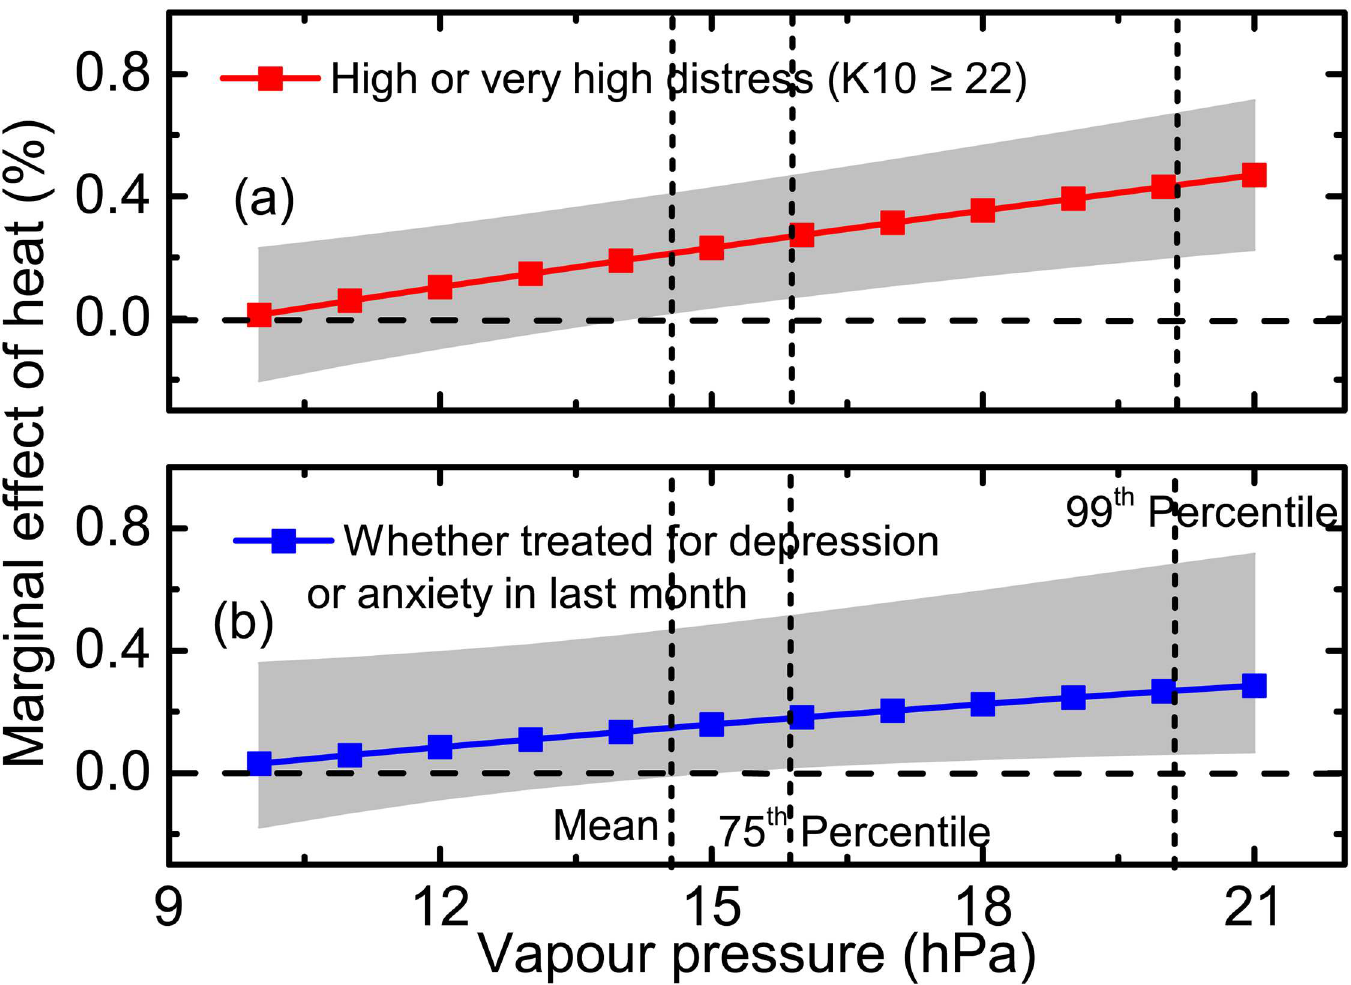
Fig 1. Marginal effects of heat on high or very high distress and on receiving treatment for depression or anxiety by humidity (vapour pressure) and their 99% confidential intervals, Logit model (Model 4), 53,144 adults aged over 45 from NSW,